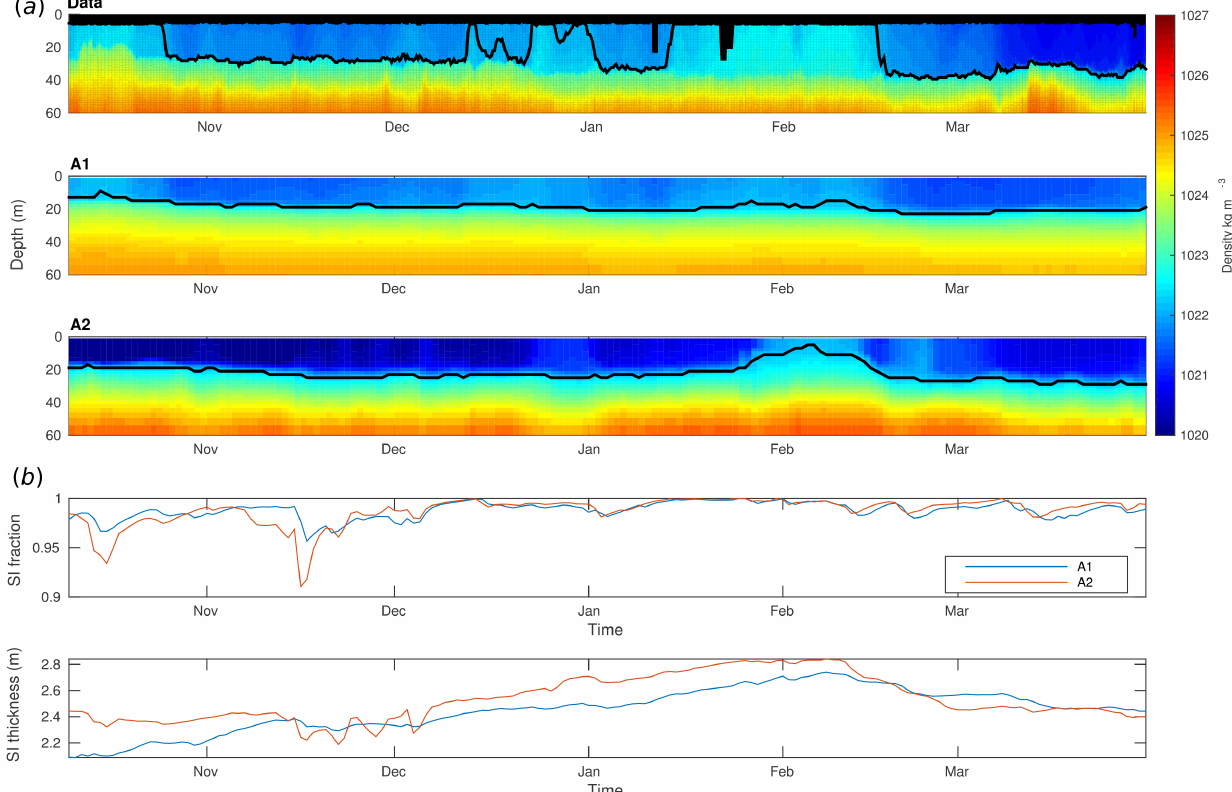
Figure 6. (a) Observed upper-ocean density vs. 36km (A1) and 9km (A2) resolution MITgcm density along the path of ITP drift; the black mask covers areas where no ITP data is available and solid black line shows isopycnal of 1022.5kgm − 3 . (b) Simulated sea ice fraction and thickness on top of the water